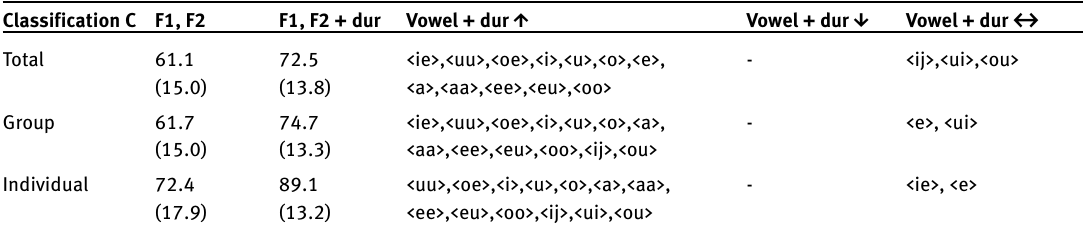
Table 4. Scores for the canonical classifications of the Dutch vowels produced by Spanish learners for the conditions “Total”, “Group” and “Individual”, with both F1 and F2 (25%, 50%, 75%) only, and F1, F2 and duration, and target vowels whose percentages (do not) change after including duration, deviations ≤ 2.5% after including duration are rated as unchanged; Clas- sification C = classification condition, + dur = including